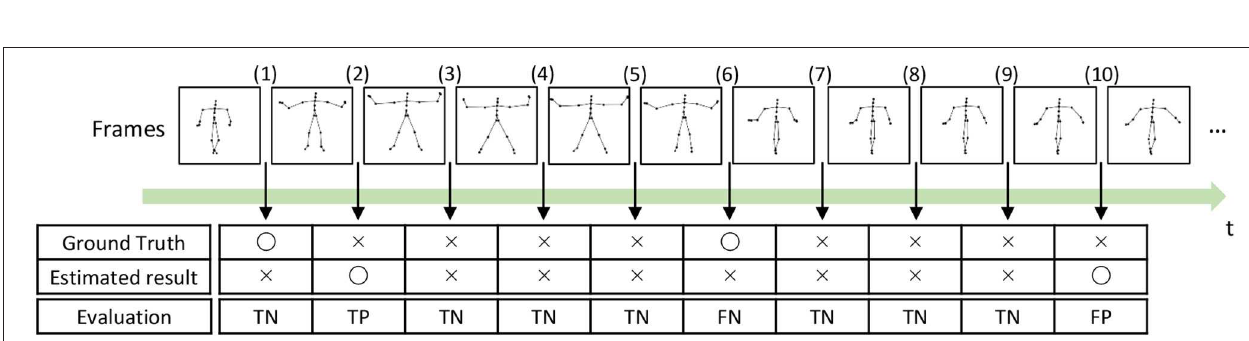
FIGURE 14 | Example of segmentation evaluation: TP is assigned to the boundary (2) because the estimated boundary is within the error range from the true boundary.